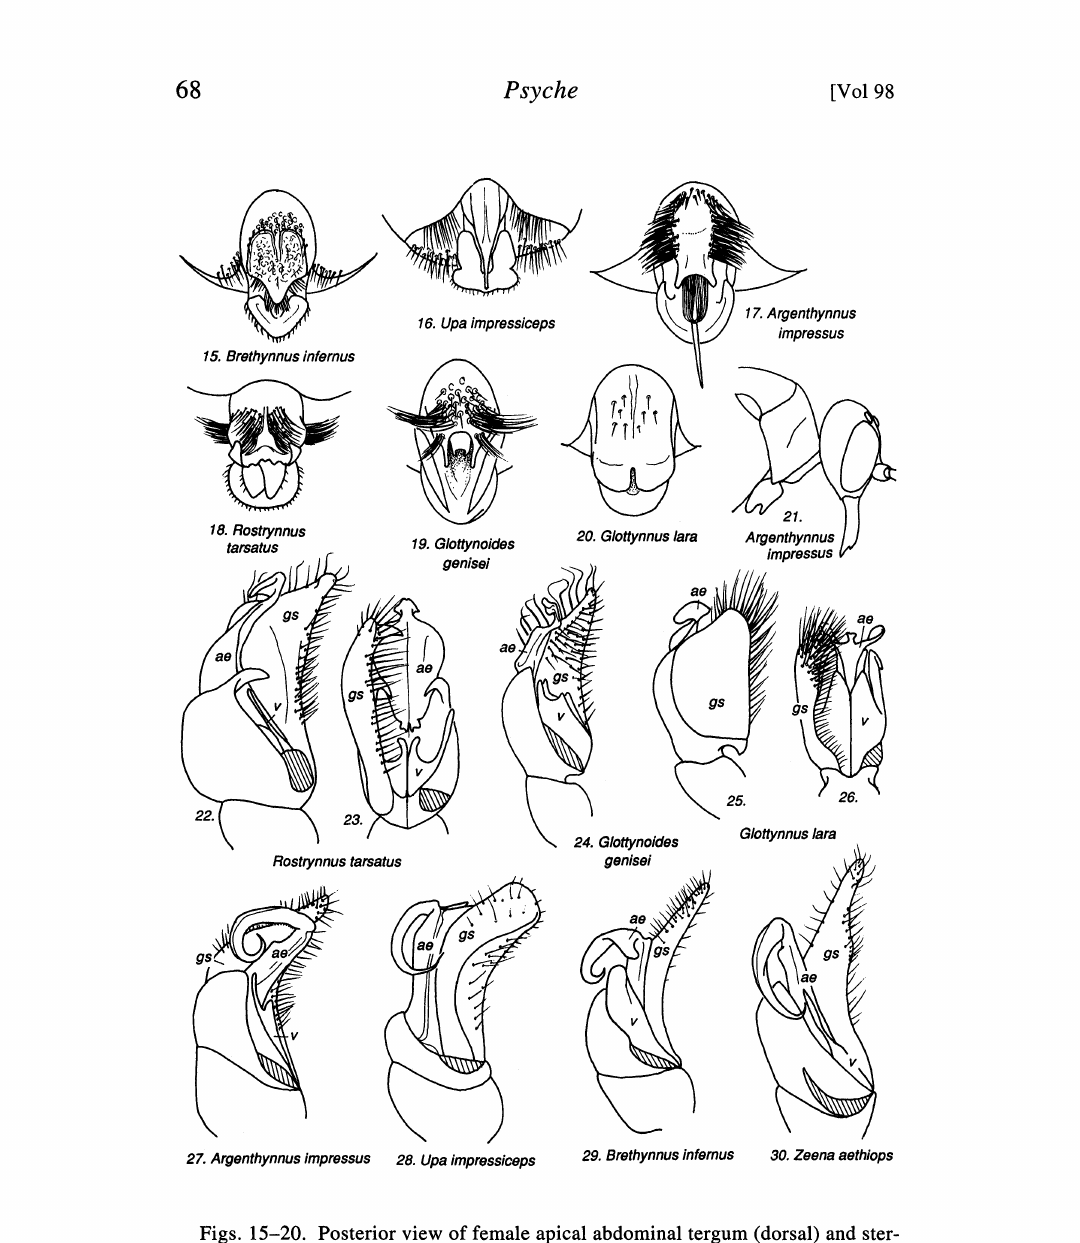
Figs. 15-20. Posterior view of female apical abdominal tergum (dorsal) and ster- num (ventral). Fig. 21. Lateral view of male head and prothorax. Figs. 22-30. Male genital capsule, ae aedeagus, gs gonostylus, v volsella. Figs. 22, 24, 25, 27-30. Lateral view. Figs. 23, 25. Ventral